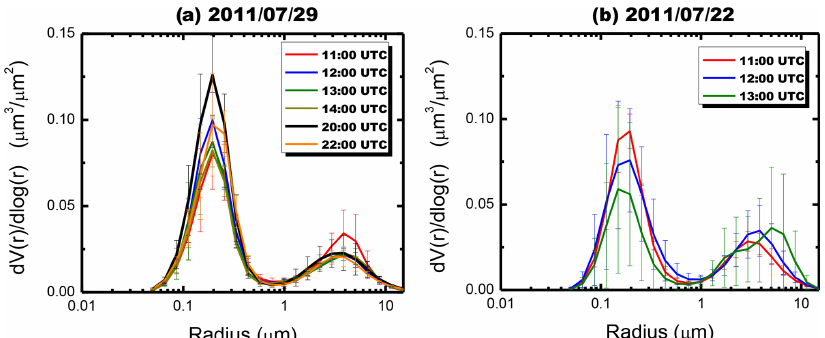
Figure 16. Mean hourly values of aerosol size distributions from AERONET-DRAGON stations over the Baltimore–Washington DC region on (a) 29 July 2011 and (b) 22 July